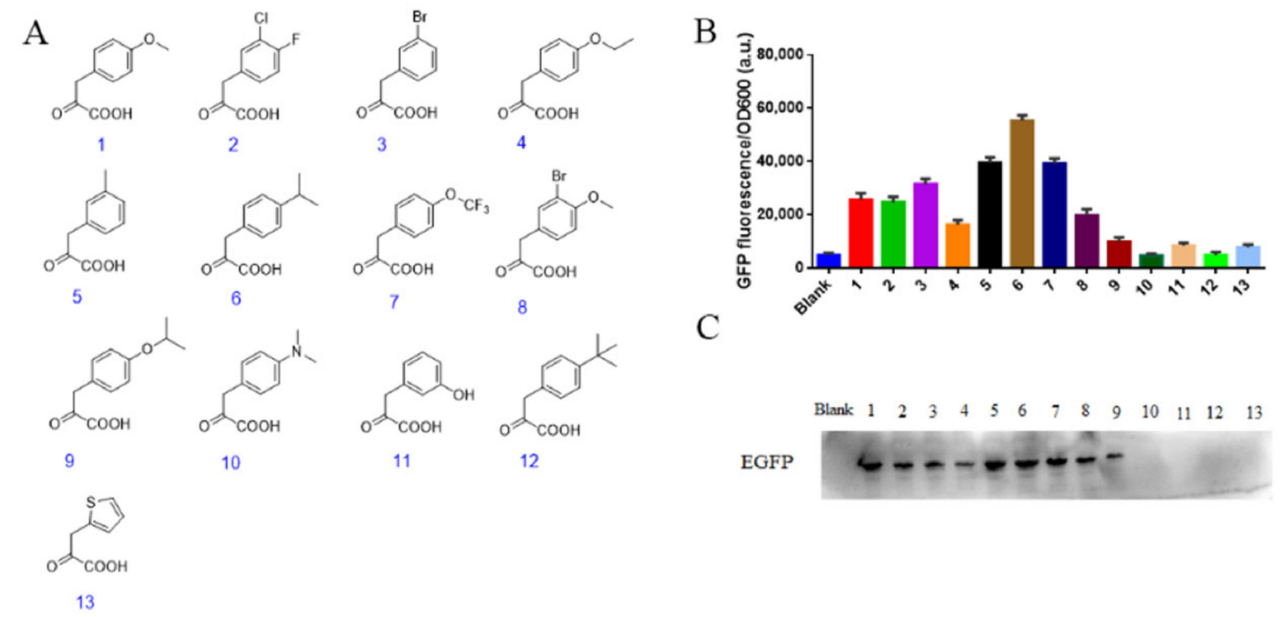
Figure 4. Incorporation of different keto acid derivatives into GFP by E. coli DH10B containing the Mm PylRS/ pyl tRNA CUA pair. ( A ) Thirteen different keto acid derivatives were synthesized. ( B ) Their incorporation into eGFP by E. coli DH10B varied, and eight resulted in high enzymic activity. ( C ) Production of eGFP was confirmed by Western blot analysis for nine keto